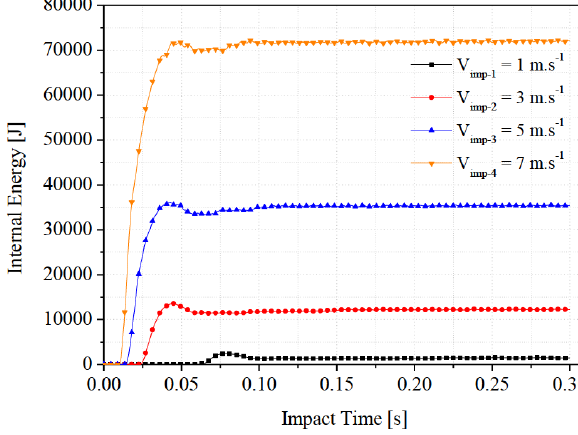
Figure 5: Boundary scheme on the hull and container during colli- sion